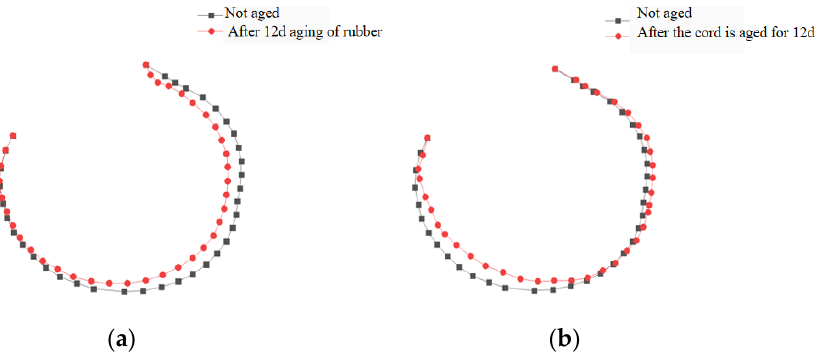
Figure 8. Schematic diagram of airbag section shape change: ( a ) considering the aging of rubber, the shape of the airbag section changes; ( b ) considering the aging of the cord, the airbag cross-sectional shape changes.